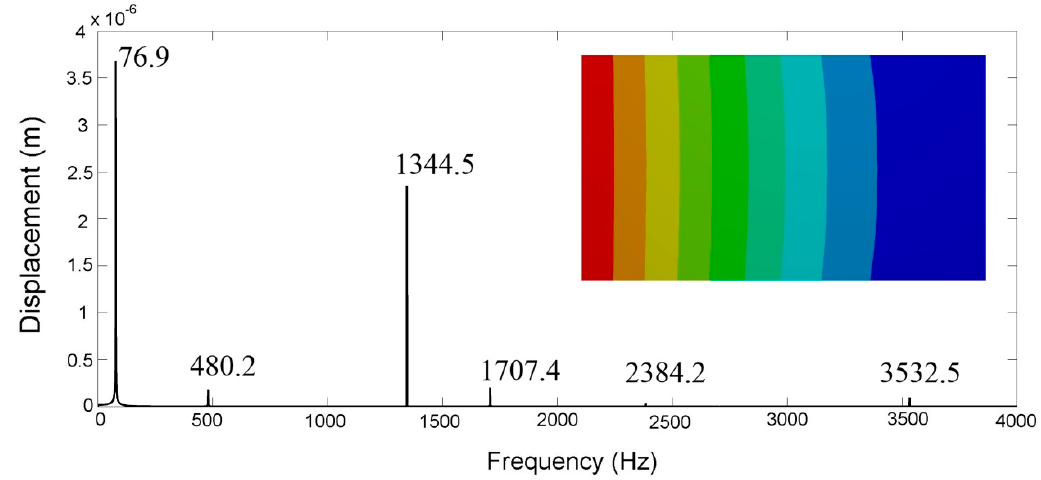
Appl. Sci. 2017 , 7 , 921 Figure 9. Simulated harmonic response with model of first bending mode at 76.9 Hz.